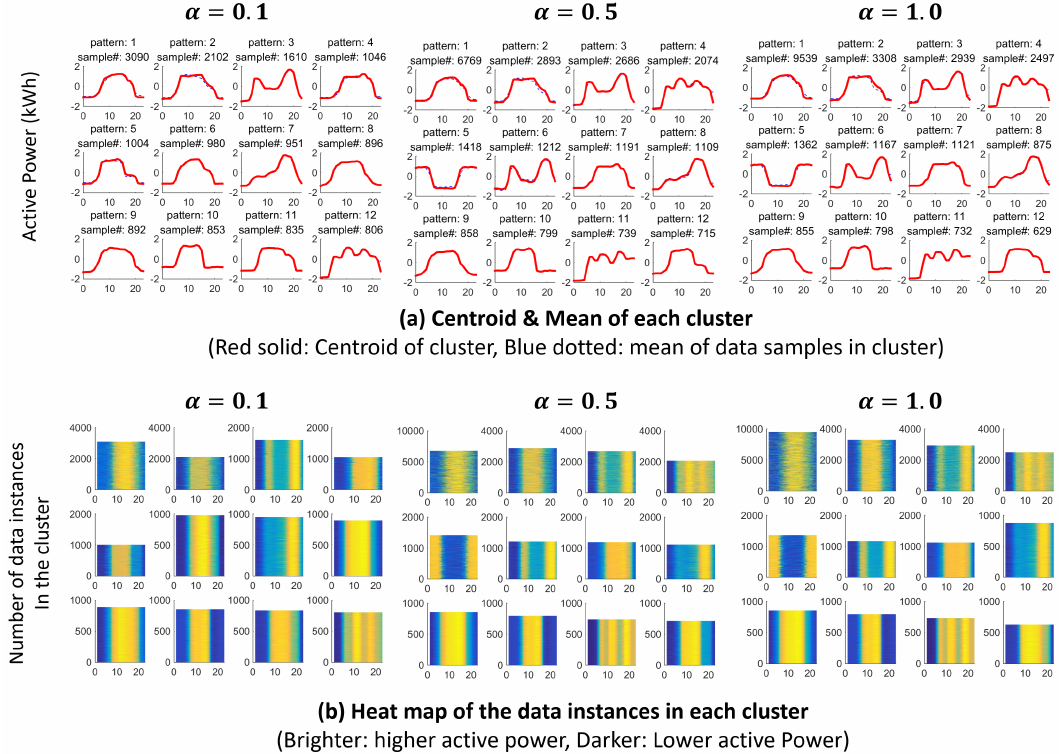
Figure 7. Clustering results of DOE data set with SPCC distance.